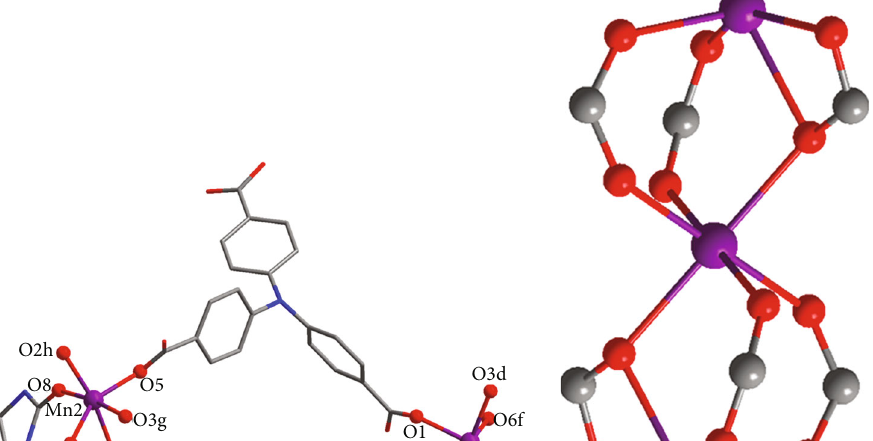
(COO) ] cluster-based 3 6